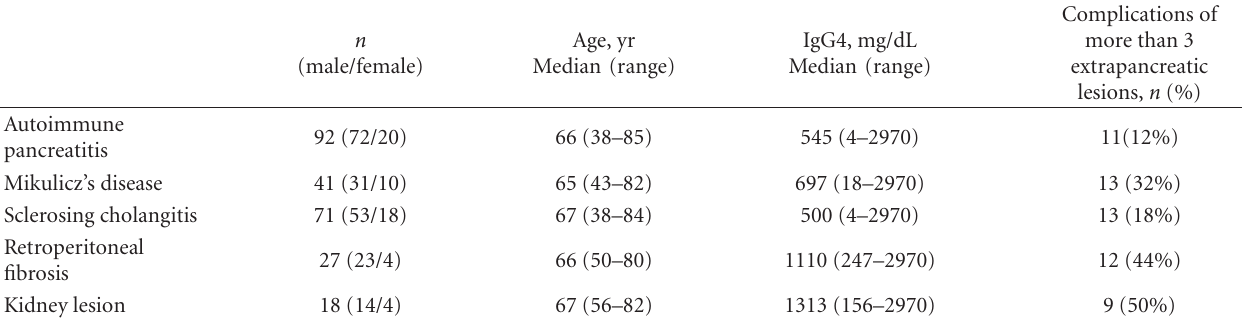
Table 1: IgG4 concentrations, age and complications of more than 3 extrapancreatic lesions in patients with autoimmune pancreatitis and major extrapancreatic